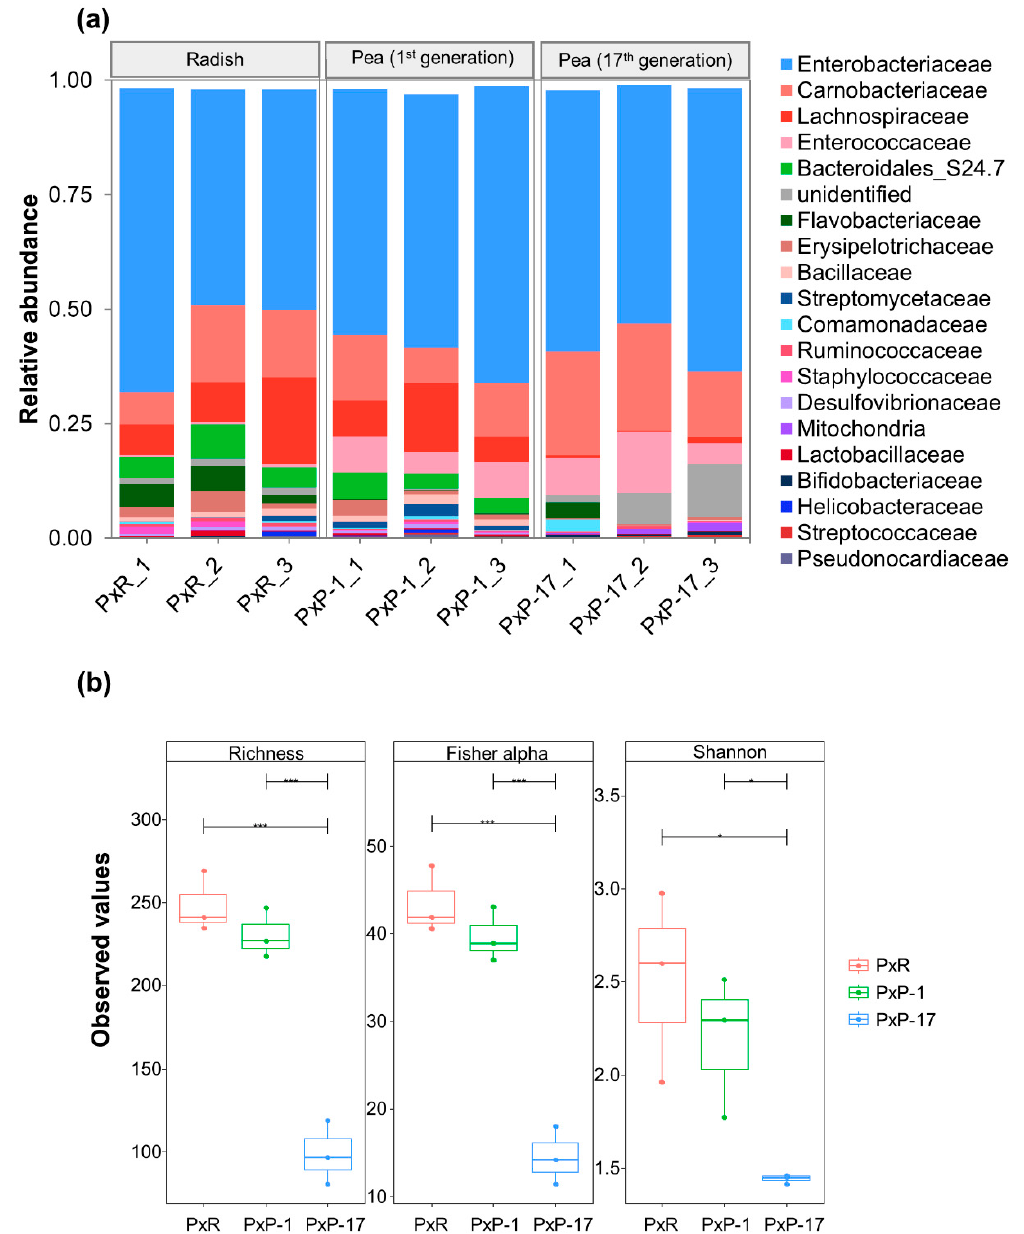
Figure 1. Gut microbial composition in different P. xylostella populations. ( a ) Relative abundance profiles at the family level; ( b ) Richness, Fisher’s alpha, and Shannon indices of gut microbiota in P. xylostella . Pair-wise ANOVA was performed between different treatments. “*” indicates p < 0.05; “***” indicates p < 0.001. PxR: P. xylostella feeding on radish; PxP-1 and PxP-17: the 1st and 17th generation of P. xylostella , respectively, feeding on peas after host shift from radish.